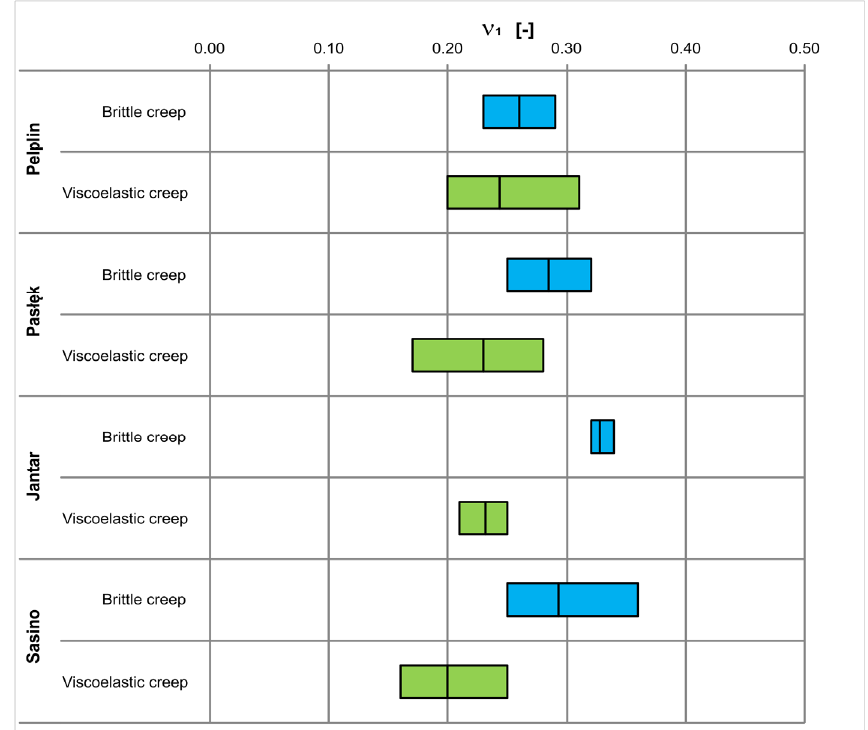
Figure 16. Comparison of ranges of Poisson’s ratio from brittle and viscoelastic creep tests for particular lithostratigraphic units.